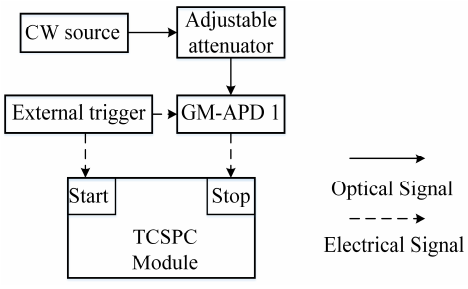
Figure 5. Autocorrelation verification system.